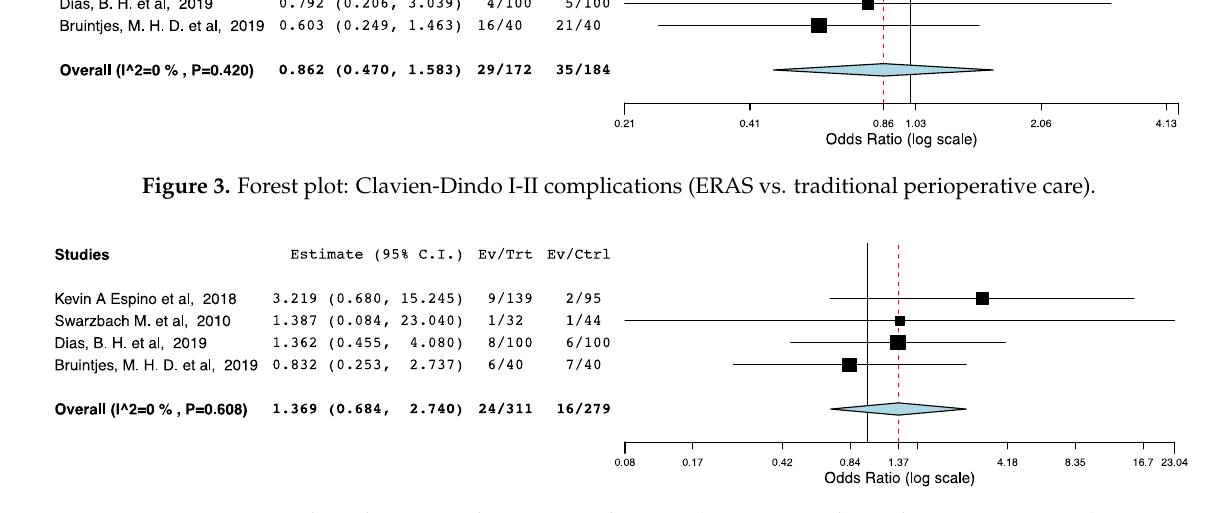
Figure 4. Forest plot: Clavien-Dindo III-V complications (ERAS vs. traditional perioperative care).